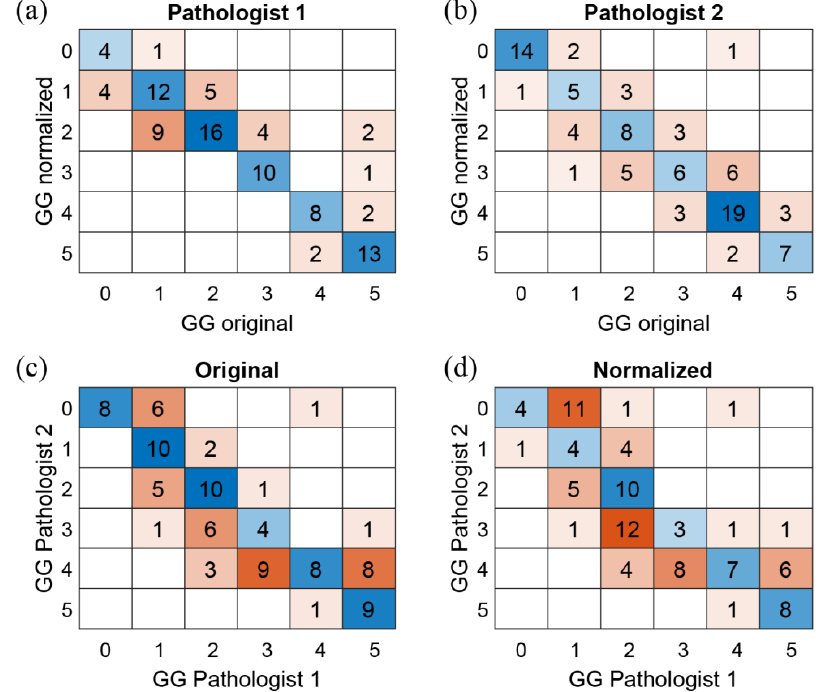
Figure 6. Confusion matrices on Gleason Grade Group (GG). First row shows the intra-agreement of P1 ( a ) and P2 ( b ) on the GG values of the original and normalized images. Second row shows the inter-agreement (P1 vs. P2) on the original ( c ) and normalized ( d ) WSIs. The clinical process is also evaluated in terms of time employed to formulate a diagnosis. In Figure 7, the overall distributions of time for diagnosis for original WSIs and normalized ones are represented for both pathologists. Specifically, for P1, the median values are 72.0 s (original) vs. 65.0 s (normalized), and for P2, the values are 39.6 s (original) vs. 30.6 s (normalized). In addition, for P1, 33% of original images have a time for diagnosis higher than 90.0 s, while only 11% of normalized images have a time for diagnosis higher than 90.0 s. For P2, 14% of original images have a time for diagnosis higher than 90.0 s, while only 2% of normalized images have a time for diagnosis higher than 90.0 s. The decrease in diagnosis time in the normalized images is statistically significant (paired-sample t test, p = 0.00015 for P1 and p < 0.0001 for P2).